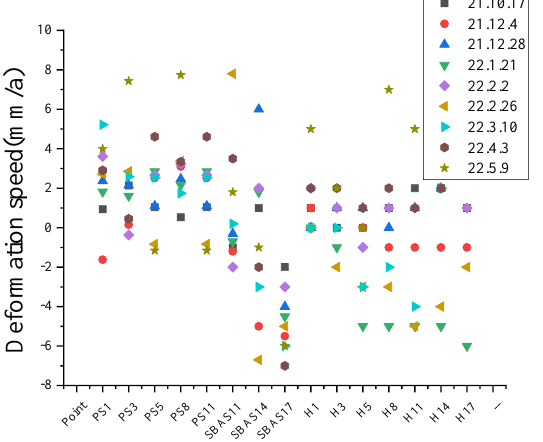
Figure 15. Relative accuracy of TS-InSAR measurement results and leveling results.